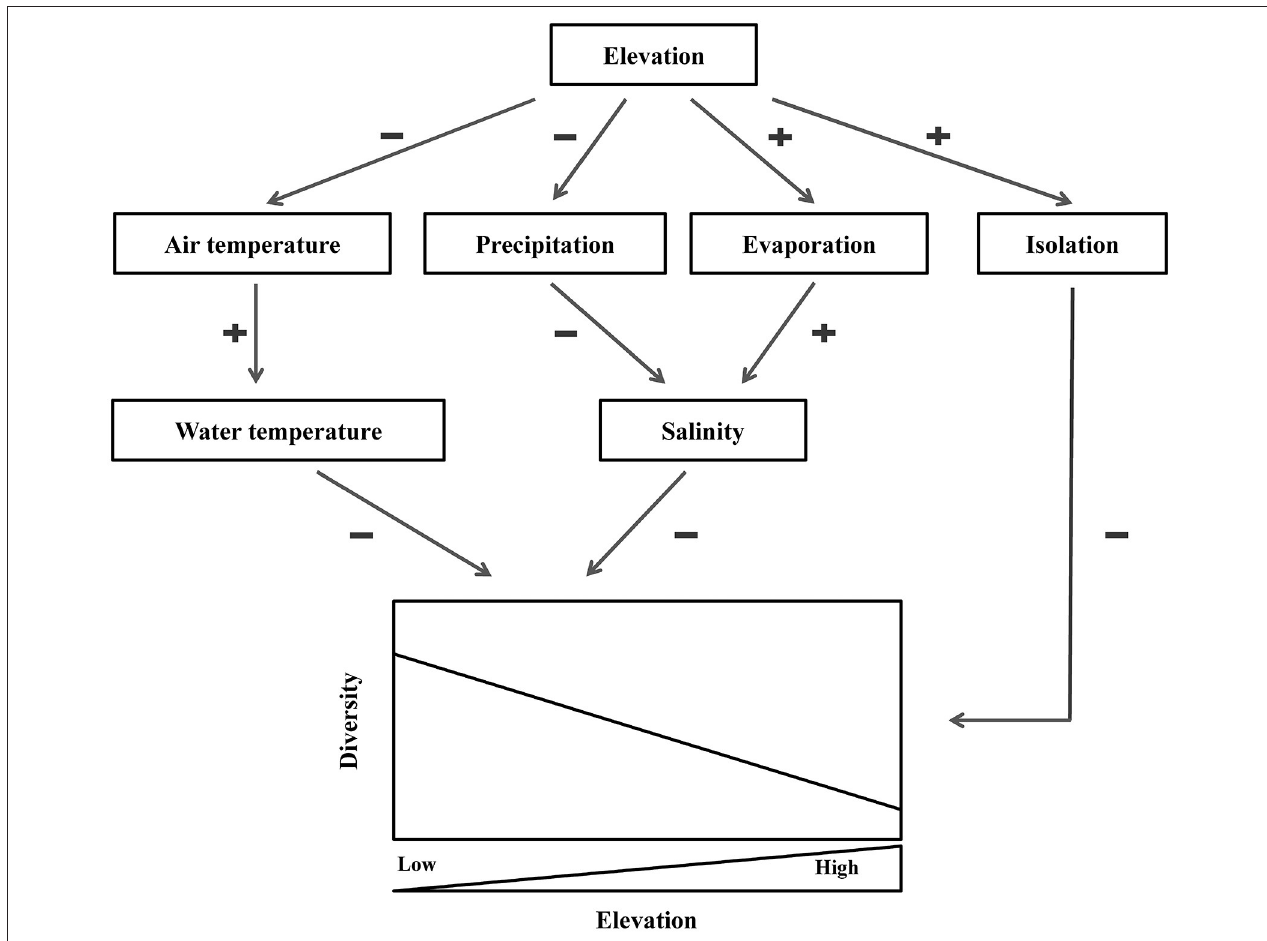
FIGURE 6 | Mechanisms of elevational effects on benthic macroinvertebrates biodiversity in lakes of China and India. “ ± ” indicate whether there is a positive or a negative tendency between two